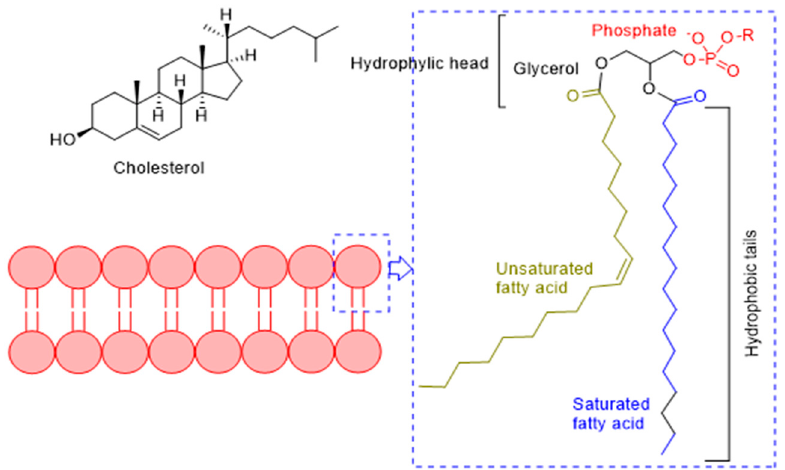
Scheme 1. Chemical structures of cholesterol and a phospholipid and illustrative representation of a phospholipid